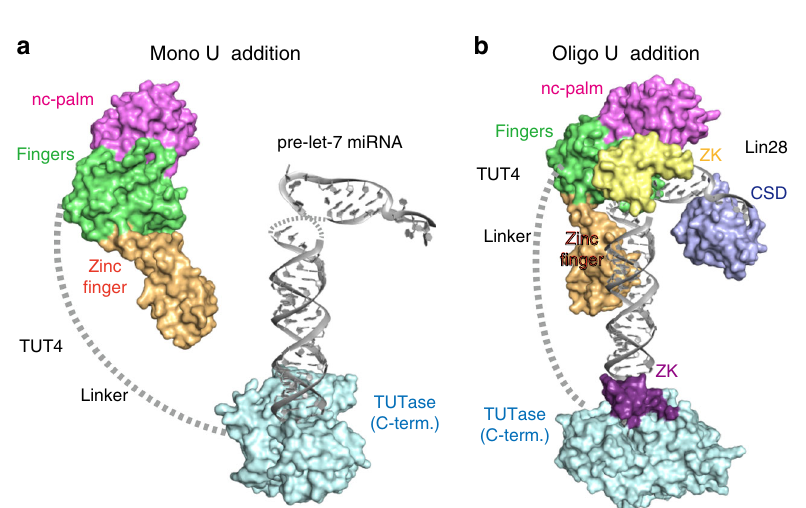
Fig. 6 A model of the oligo-uridylylation of pre-let-7 by TUT4. a Structural models of the mono-uridylylation of 3 ’ -end of pre-let-7 by human TUT4 in the absence of Lin28 and b oligo-uridylylation of the 3 ′ -end of pre-let-7 by human TUT4 in the presence of Lin28. The zinc fi nger, palm, and fi ngers domains of hTUT4_N are colored orange, magenta, and green, respectively. The catalytic TUTase domain and the zinc knuckle in the C-terminal half of TUT4 are colored cyan and purple, respectively. The internal linker region is shown by a dotted gray line. The cold shock domain (CSD) and the tandem zinc knuckles (ZK) of Lin28 are colored blue and yellow,